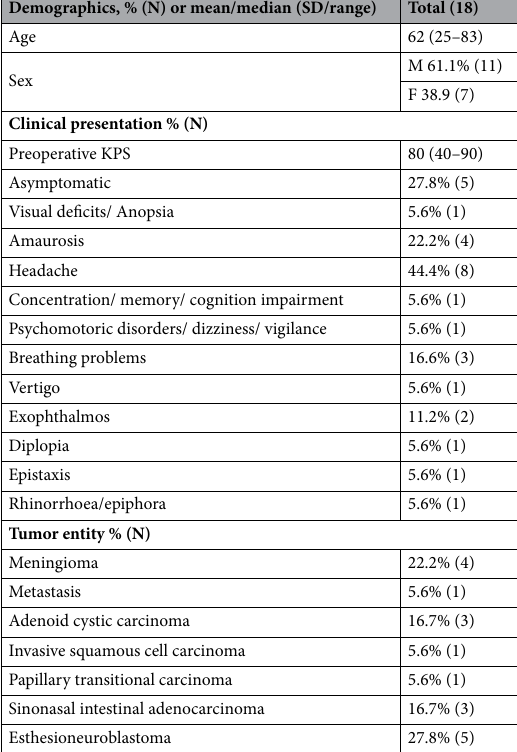
Table 1. Demographics, preoperative and tumor